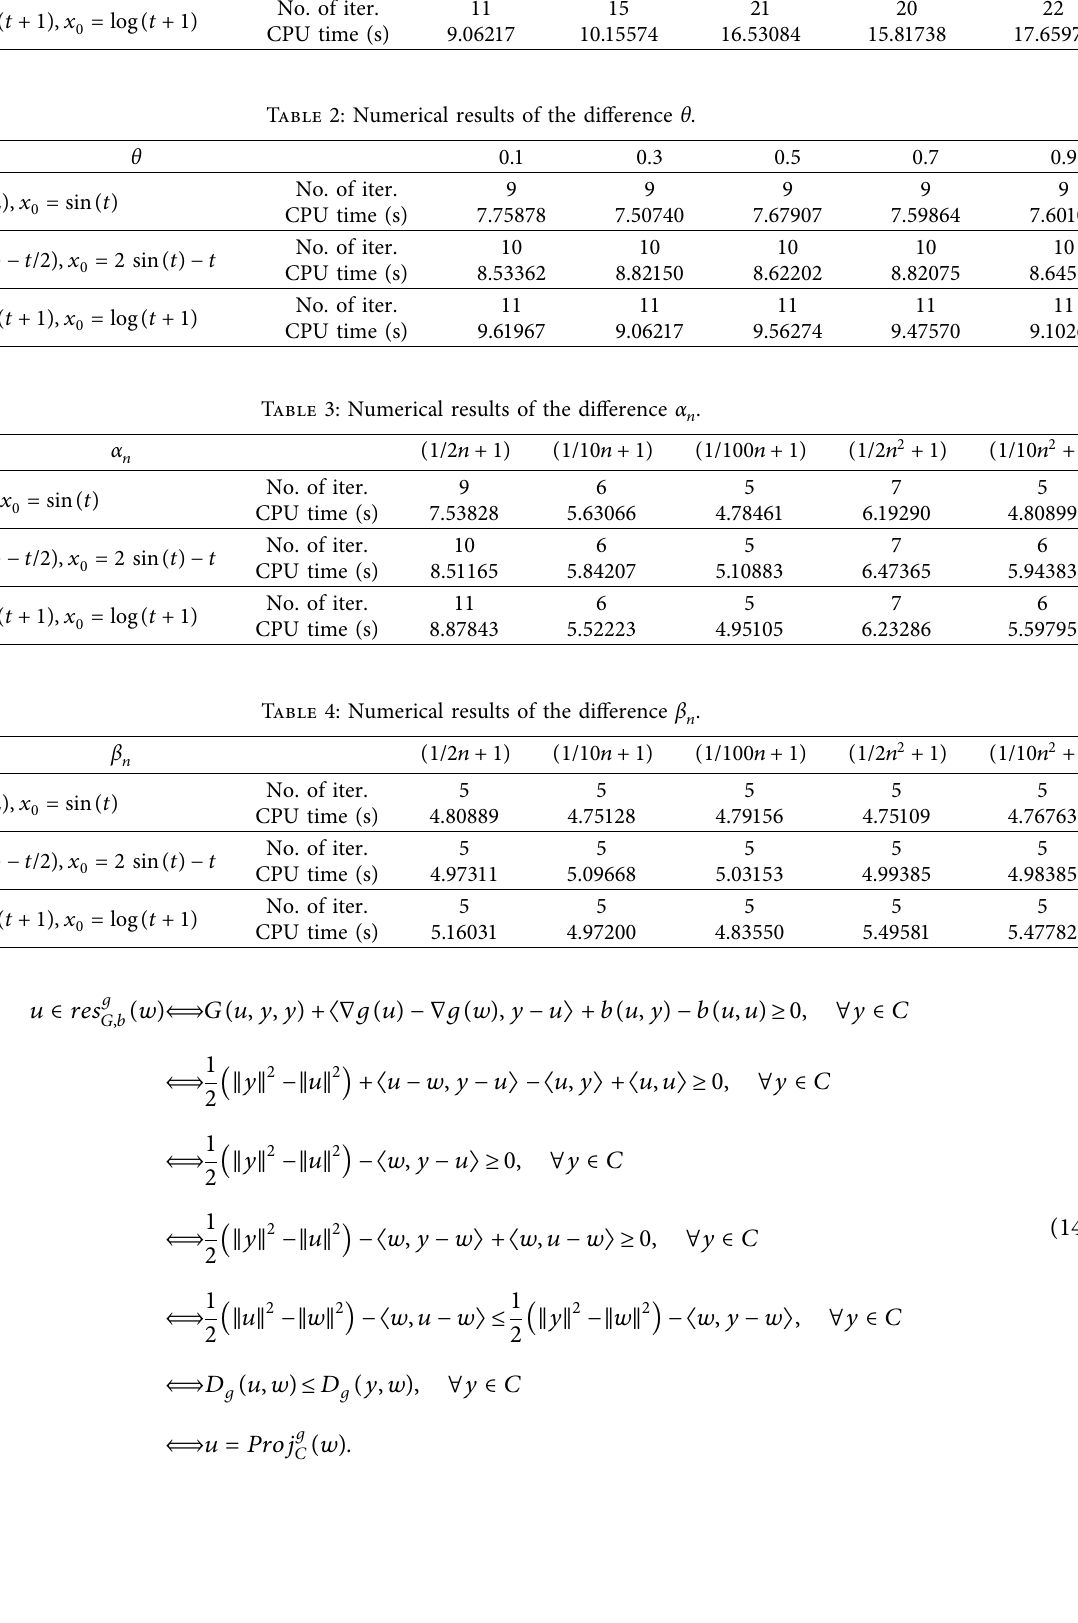
Table 1: Numerical results of the difference ε